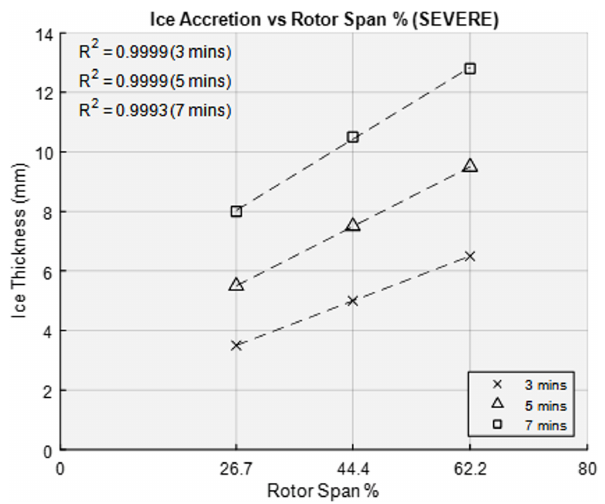
Figure 14. Ice thickness measurements for the severe icing condi- tion.